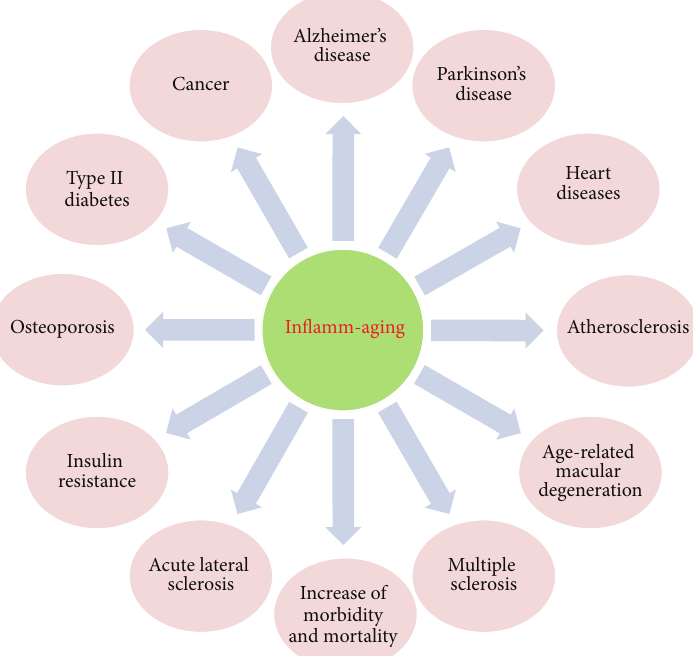
Figure 1: The relationship between inflamm-aging and